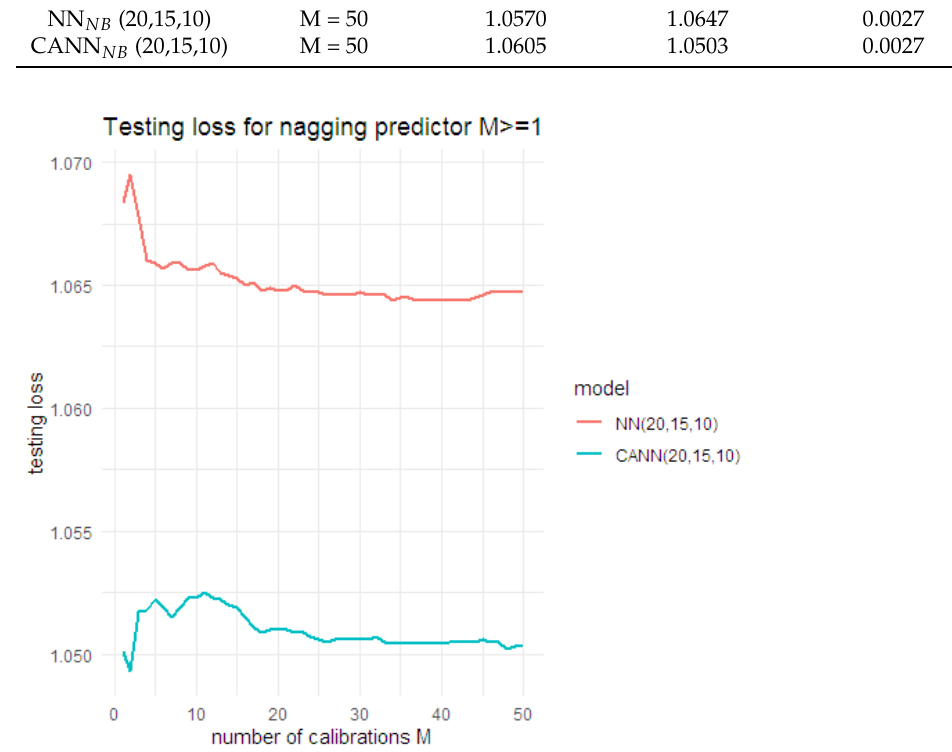
Figure 12. Testing loss for the nagging predictors under the negative binomial NN and CANN models, using (20,15,10)